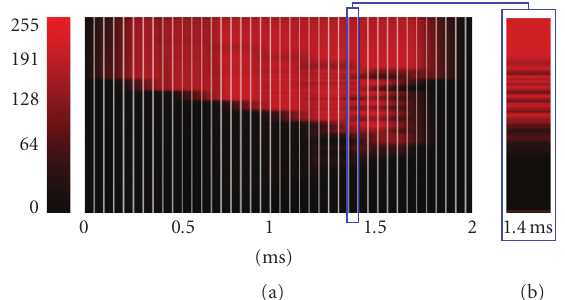
Figure 3: (a) Detailed mirror flip sequences for all 256 values in the red channel with the starting exposure times ranging from 0 to